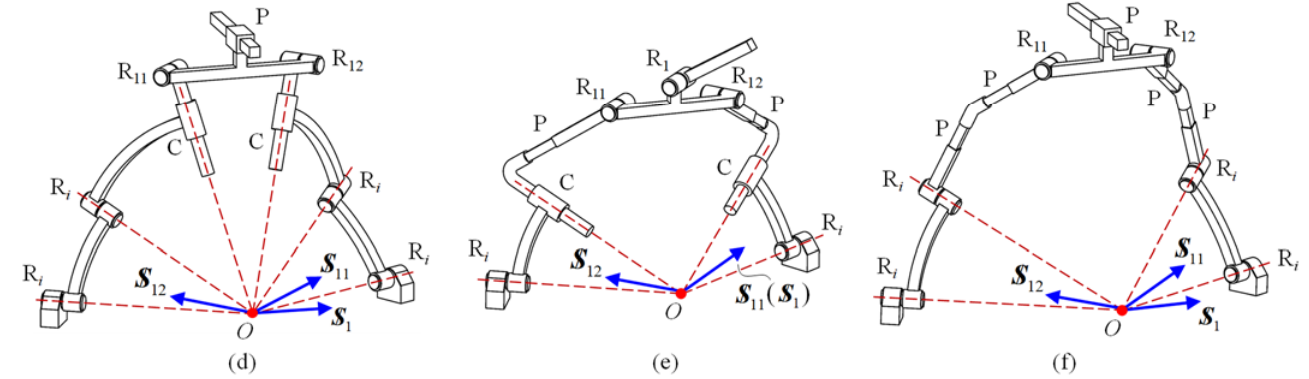
Figure 3. Typical F ‐ hybrid limbs in the first class: ( a ) [R i R i R 11 R 11 R 11 ‐ R i R i R 12 R 12 R 12 ] ‐ R 1 , ( b ) Figure 3. Typical F-hybrid limbs in the first class: ( a ) [R i R i R 11 R 11 R 11 -R i R i R 12 R 12 R 12 ]-R 1 , ( b ) [R i R i R i R 11 R 11 - [R i R i R i R 11 R 11 ‐ R i R i R i R 12 R 12 ] ‐ P, ( c ) [R i UPR 11 ‐ R i UPR 12 ] ‐ R 1 , ( d ) [R i R i CR 11 ‐ R i R i CR 12 ] ‐ P, ( e ) [R i CPR 11 ‐ R i R i R i R 12 R 12 ]-P, ( c ) [R i UPR 11 -R i UPR 12 ]-R 1 , ( d ) [R i R i CR 11 -R i R i CR 12 ]-P, ( e ) [R i CPR 11 -R i CPR 12 ]-R 1 , R i CPR 12 ] ‐ R 1 , ( f ) [R i R i PPR 11 ‐ R i R i PPR 12 ] ‐ P. ( f ) [R i R i PPR 11 -R i R i PPR 12